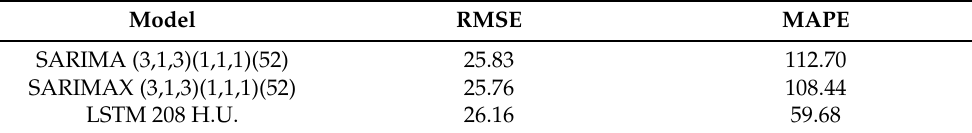
Table 1. Summary of the performance metrics obtained by the 3 models studied.